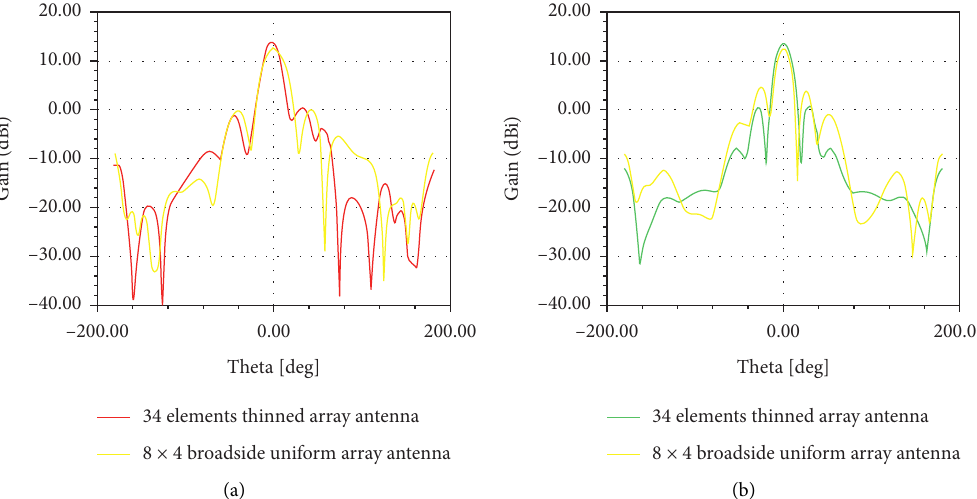
Figure 11: Comparison of radiation pattern between 34 elements thinned array antenna and 8 × 4 broadside uniform array antenna in E- plane (a) and H-plane (b).